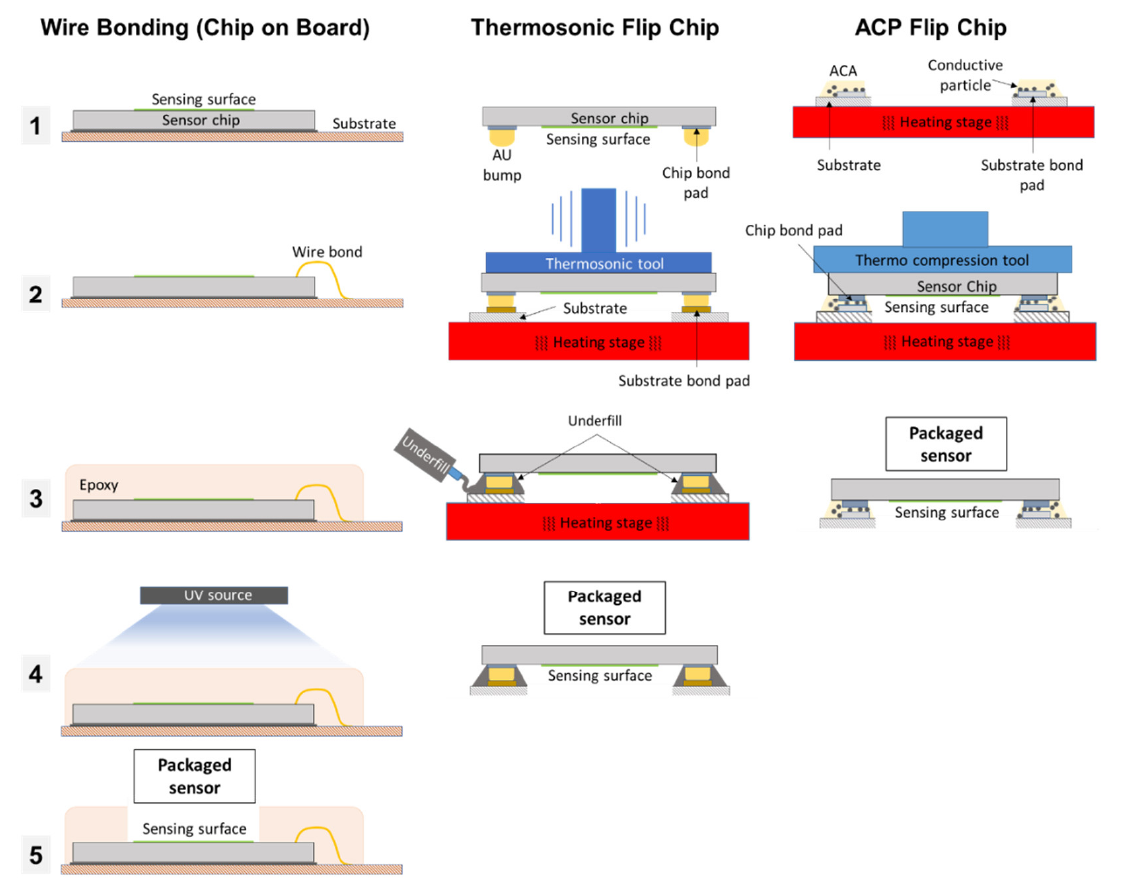
Figure 3. Schematic comparison among the ACP, thermosonic flip chip, and the wire bonding integration process flow to realize a sensor package with an exposed cavity. The sensing area of the chip is colored green.